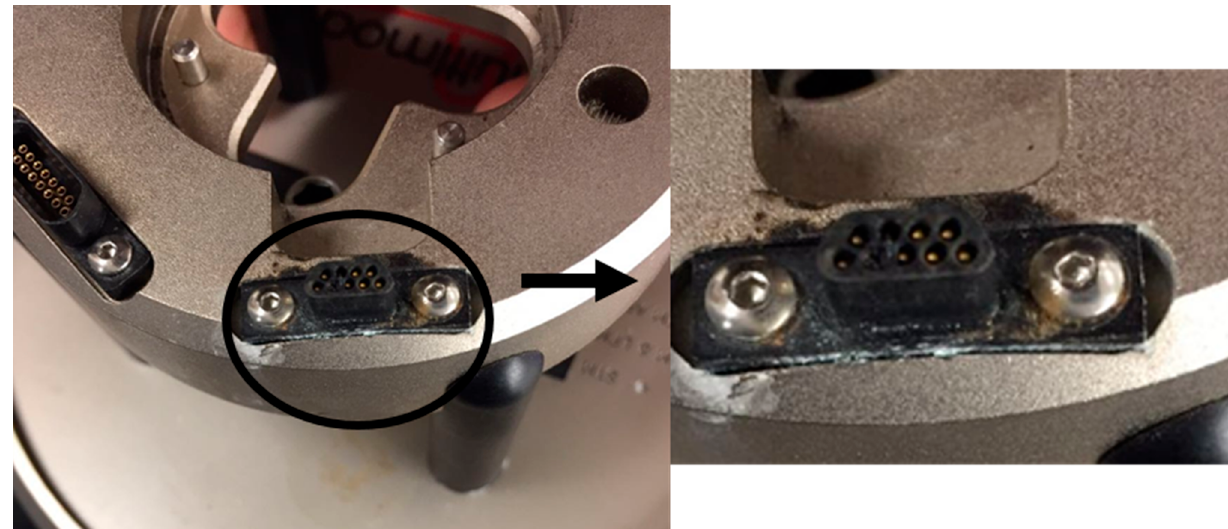
Figure 10. Corrosion on the base of an atomic force microscopy (AFM) following contact with a mixture containing 70% wt. Dead Sea brine and 30% wt. seawater. The concentration of Cl − in this mixture is about 3.86 m .